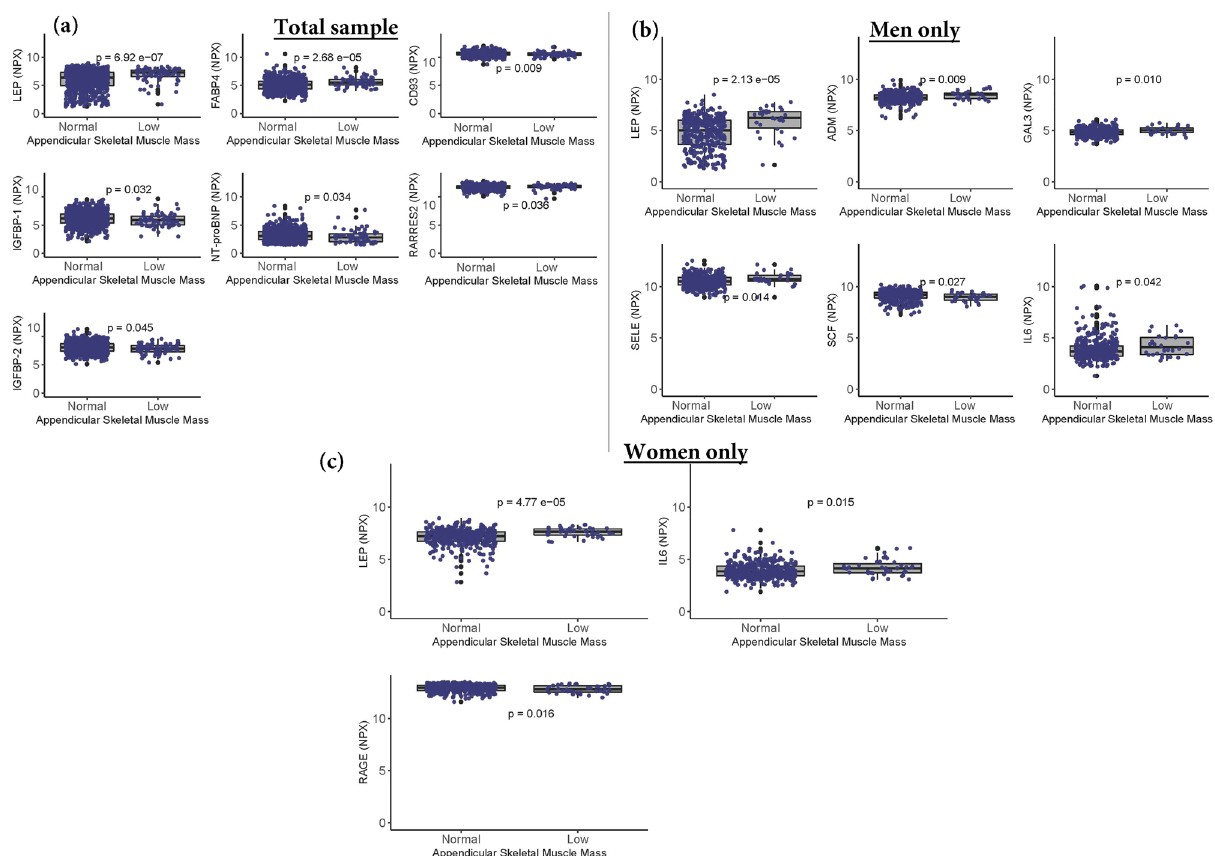
Figure 4. Comparison of biomarkers between participants with normal and low ASM. The Wilcoxon rank-sum test was used to compare groups. The box and whisker plots represent medians and interquartile ranges. NPX: Normalized protein expression; p: P value. Full names of all biomarkers are listed in Additional Table